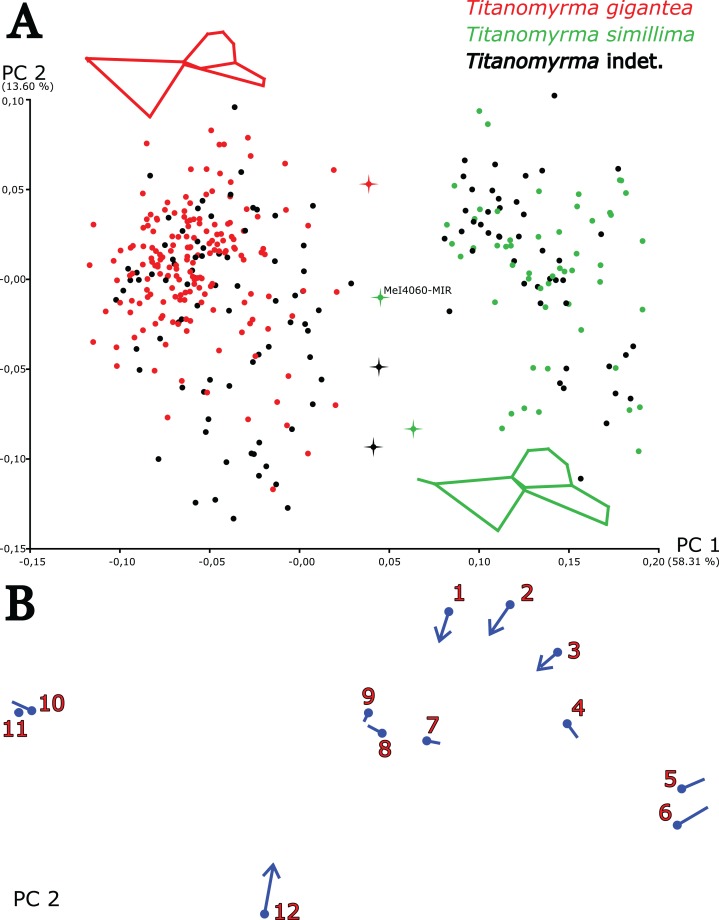
PCA of Titanomyrma specimens from Messel.The analysis was performed in SD 3. (A) Wireframes represent the mean shapes of the respective species. High values in PC1 (58.31%), where T. simillima clusters, signify the branching of m-cu—farer off from M1, more distance between M1 and cu-a, a more pronounced rs-m, and larger relative sizes of cells 1-2R and 1Rs. Low values in PC1, where T. gigantea clusters, signify the opposite. Problematic specimens are marked with crosses (see Table S3). (B) High values in PC2 (13.60%) mean a narrower wing in general, expressed by the shape shift of LM1, 2, 3, and 12. The lollipop graph dots indicate the mean shape of Titanomyrma specimens from Messel, lines stretch out in positive PC-value-shape change and end in with the value of 0.10 in PC2.